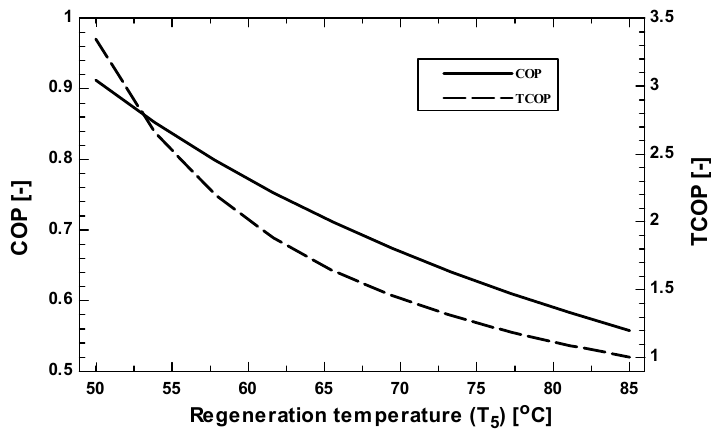
Figure 6. Effect of regeneration temperature on the system performance.